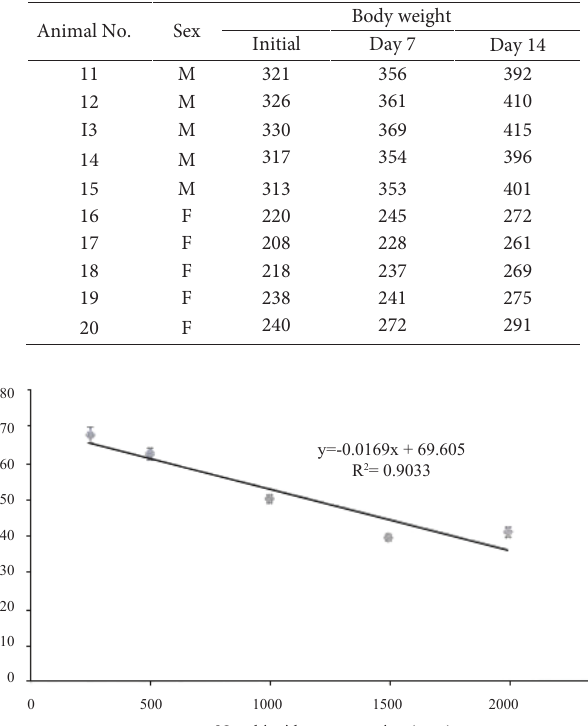
Table 5. Individual body weights of test group Animal No.